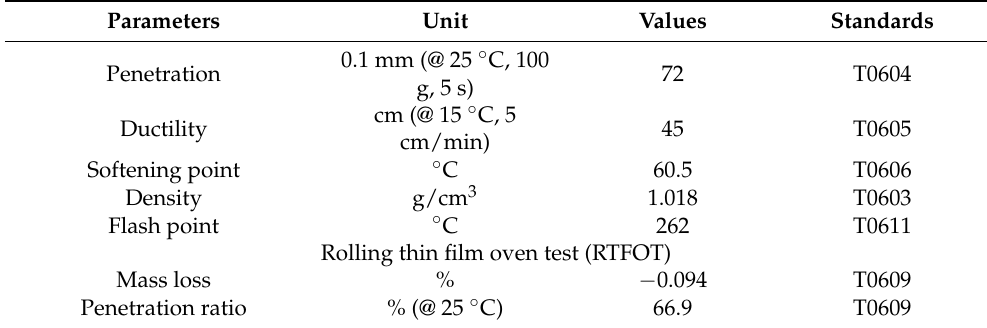
Table 1. Technical properties of SBS-modified asphalt.